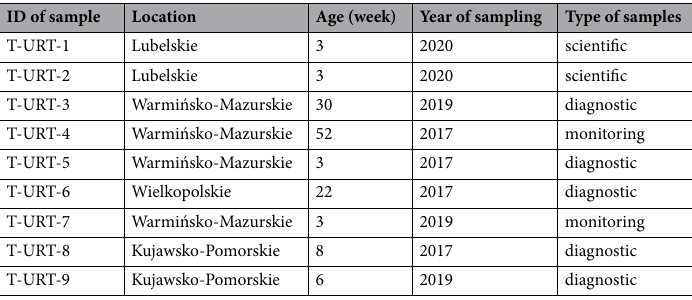
Table 2. Flock metadata.